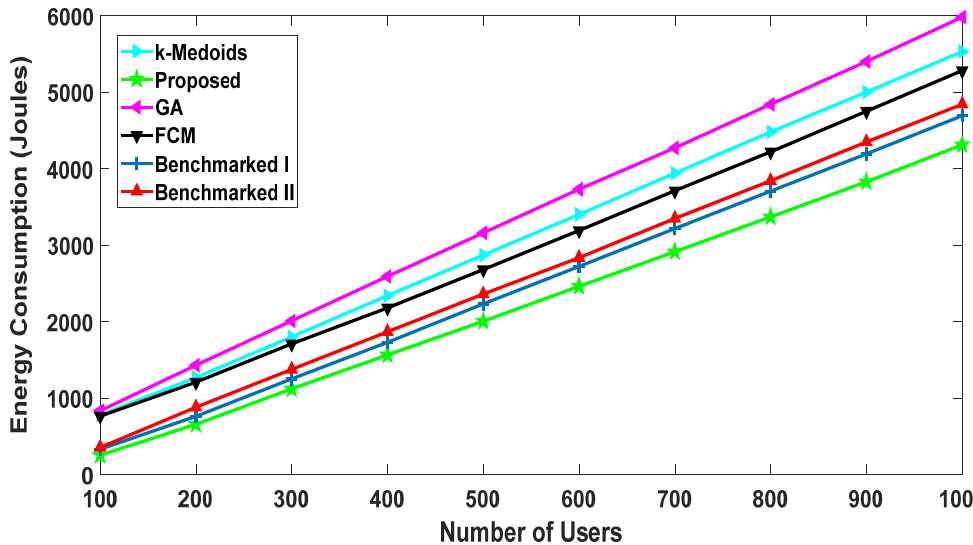
Figure 10. Energy consumption: comparison with the benchmarked ( 𝑤 (cid:2869) (cid:3404) 0.4,𝑤 (cid:2870) (cid:3404) 0.6 ).